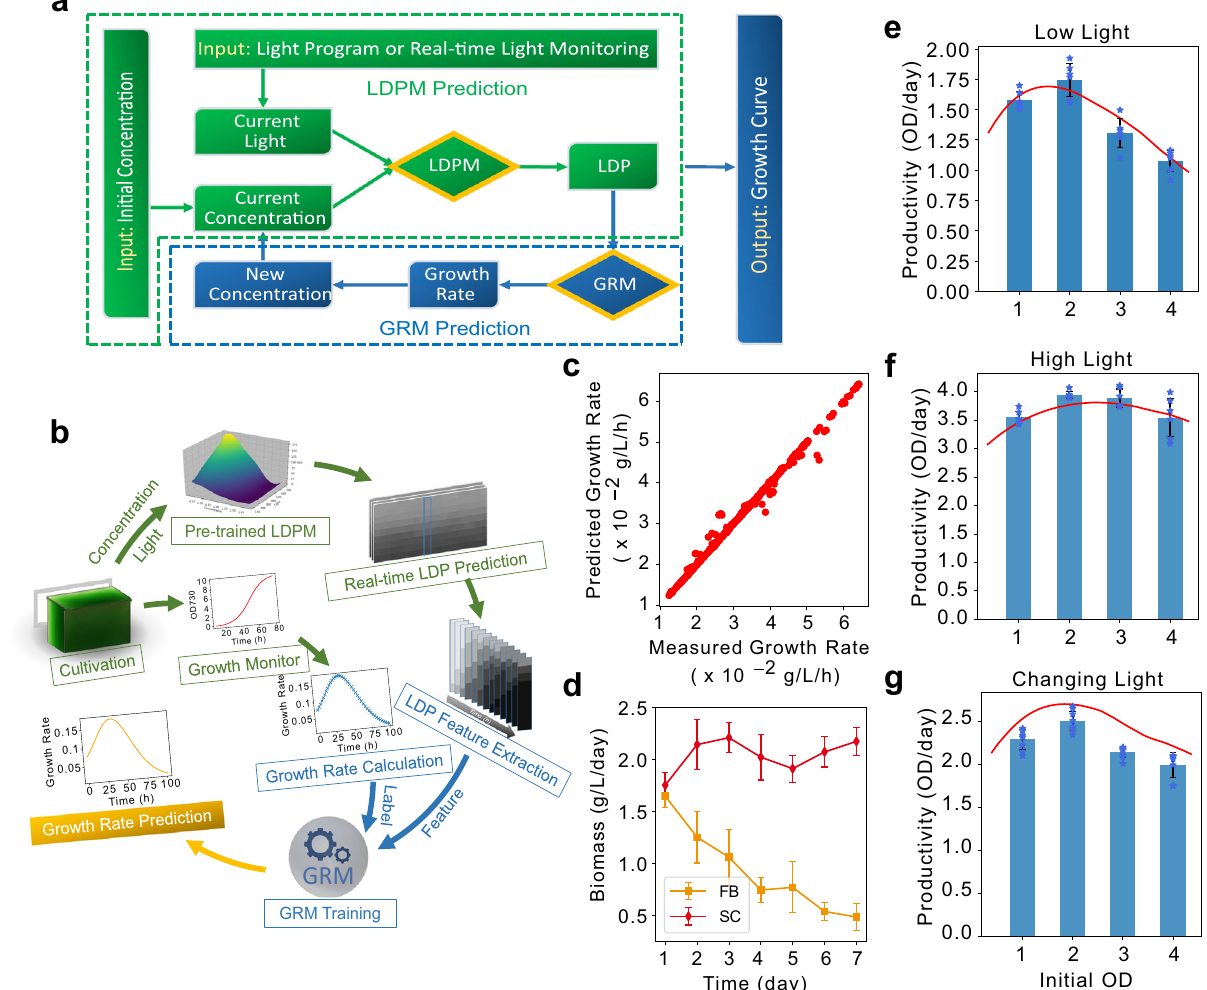
Fig. 2 Growth rate prediction, growth simulation and semi-continuous algal cultivation (SAC). Overview of work fl ows for growth simulation and GRM training are shown in a and b, respectively. The growth simulation could be achieved by integrating the LDPM (Green) with an additional growth rate prediction model, GRM ( a , Blue). The LDP features predicted by LDPM and corresponding growth rates calculated from growth curves were used as features and labels, respectively, in the GRM training ( b ). The accuracy of GRM prediction was evaluated and shown in c , with an R 2 score of 0.992, indicating high precision. The cyanobacterial growth (biomass production) with different initial OD under low light ( e ), high light ( f ), and changing light ( g ) were simulated (red lines) and monitored (blue columns). The similar trends between simulations and measurements veri fi ed the accuracy of the simulation and legitimized the simulation as a reliable tool to inform algal cultivation system development. After light condition optimization, biomass productivity from machine learning-informed SAC was evaluated, with fed-batch as control. The biomass productivities sustain at around 2 g/L/day over 7 days in SAC ( d , SC) while they decreased over time in fed-batch ( d , FB). Original data points of bar fi gures ( e – g ) are shown on the plot with blue stars. Data are presented as mean values ±standard deviations ( n = 3 independent samples with three technical replicates). Source data are provided as a Source Data fi